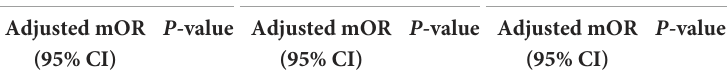
TABLE 2 Factors associated with household food security status. Household food security